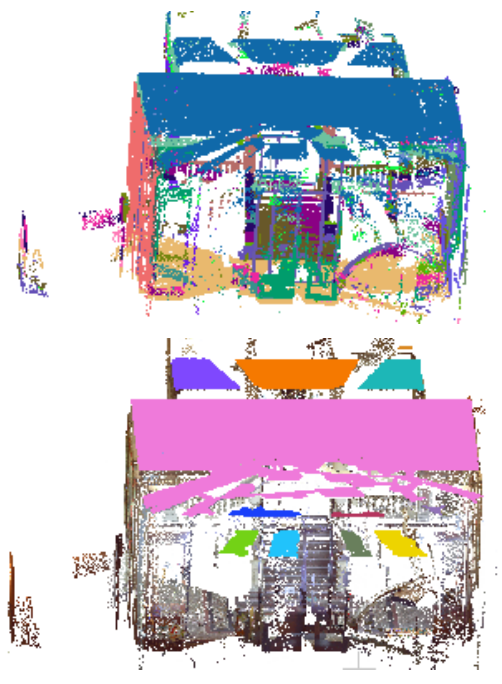
Figure 8. Top: Inliers of the estimated planes from an indoor scan, Bottom: Polygons extracted from the prominent plane.